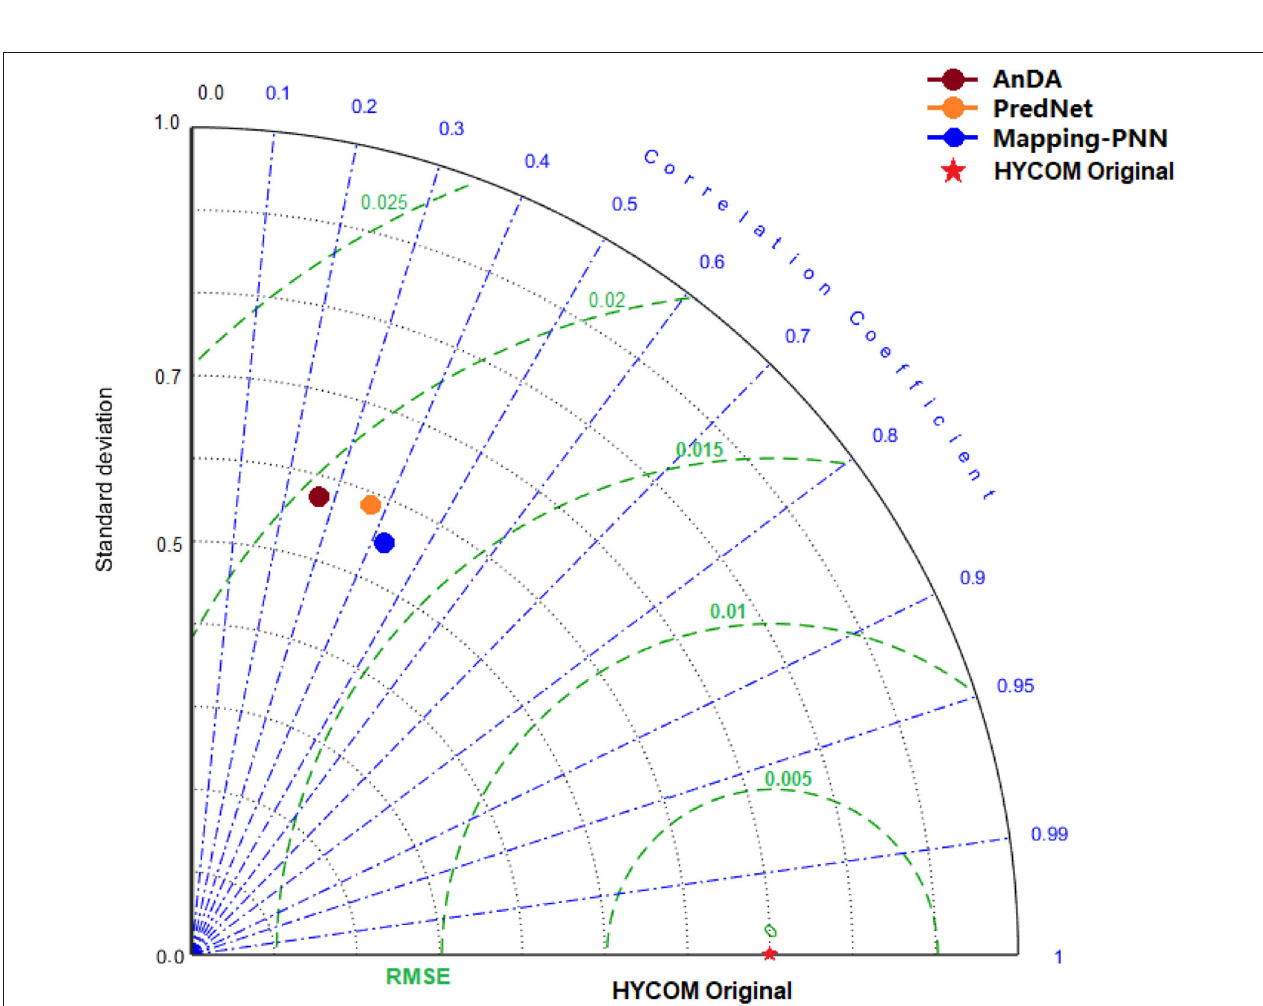
FIGURE 6 | The Taylor Diagram computed for the AnDA, the PredNet, and the Mapping-PNN methods, respectively.